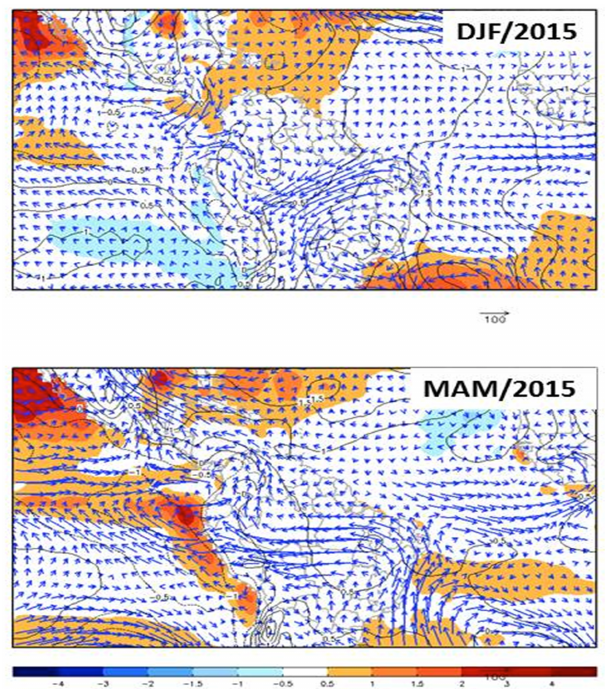
Figure 2. Seasonal SST anomalies ( ◦ C), SLP anomalies (hPa) and anomalies of vertically integrated moisture transport (vectors) from the surface to 500hPa in South America from December 2014 to May 2015. SST and circulation anomalies correspond to the 1961– 2012 long-term mean. The bar at the bottom of the panel shows the scale of the SST anomalies. The vector at the bottom of the panel shows the scale of the moisture transport (kg − 1 ms − 1 ) . Black full lines show SLP anomalies